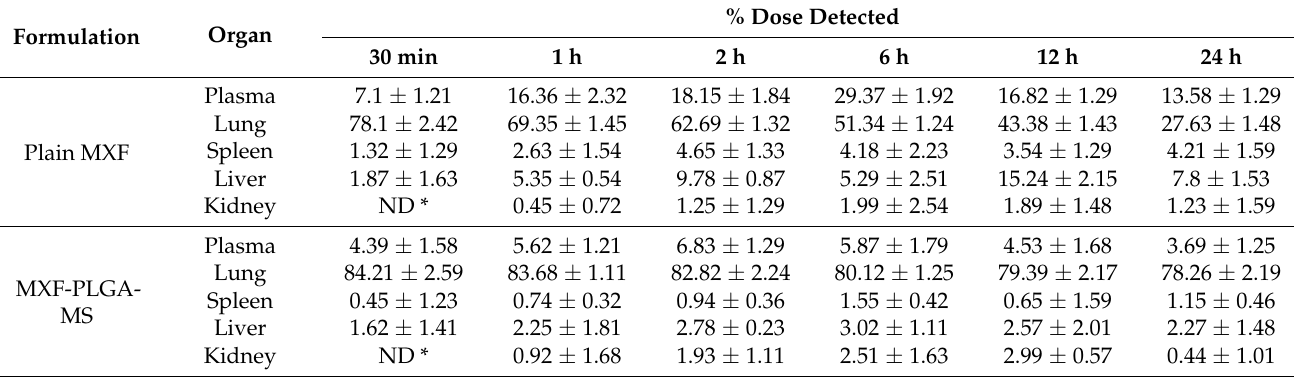
Table 5. Organ bio-distribution of plain MXF and MXF-PLGA-MS following pulmonary administration.